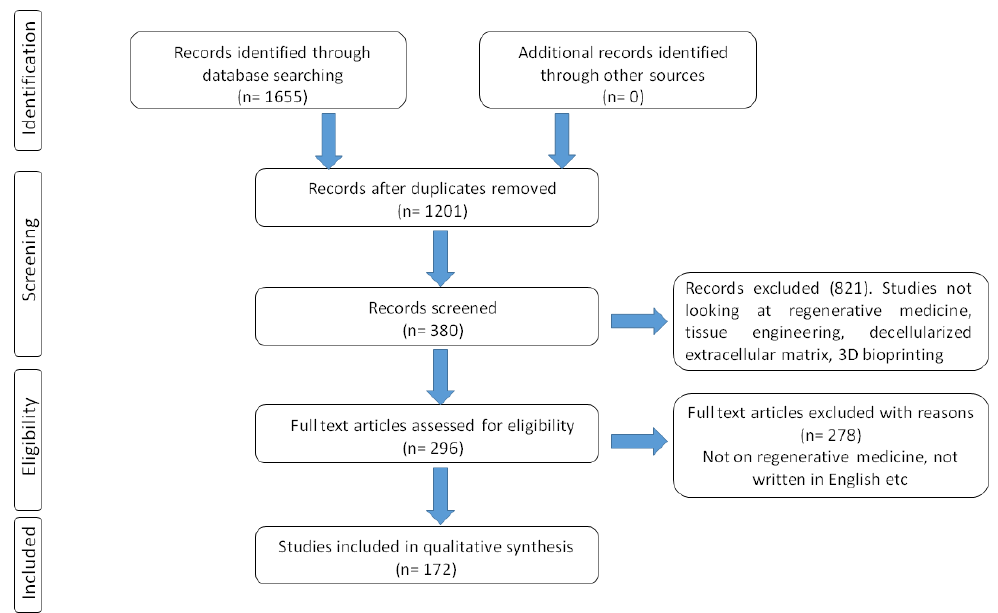
Figure 2. Selection of studies included in the qualitative synthesis of the review manuscript.